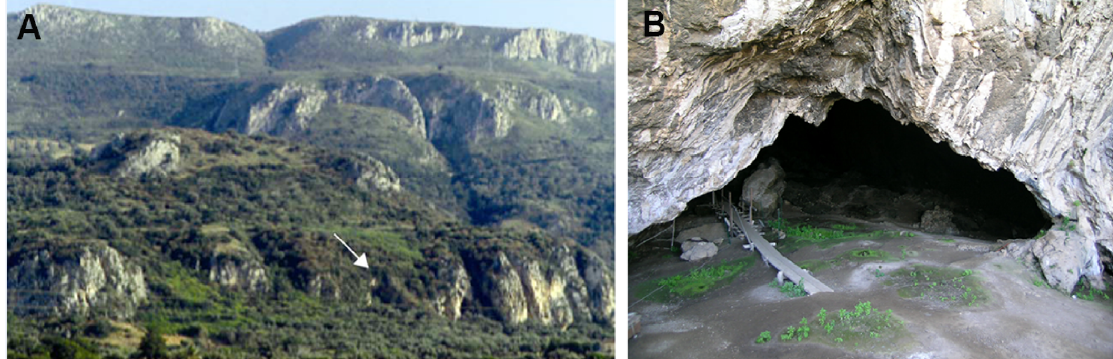
6 of 23 Figure 4. Palaeogeography of Sicily in the middle Pleistocene against present-day coastline (yellow contour). The Hyblean Plateau formed an island separated from the rest of Sicily (from [27], modi- fied). In Sicily five Faunal Complexes (FCs) of Quaternary vertebrate fauna have been dis- tinguished based on bio-events (extinctions and new arrivals) and evolution of endemic species [6,13,14]. Among these FCs, or continental biochronological units, three have been recognised in the examined caves: the P. falconeri FC (early middle Pleistocene, probably MIS 22-11), the Maccagnone (formerly P. mnaidriensis ) FC (late middle Pleistocene, prob- ably MIS 10-4) and the San Teodoro FC (late Pleistocene, 32,000 ± 4000 yr BP, after 230 Th/ 234 U dating on a concretion [30]. 3. Description of the Caves 3.1. San Teodoro Cave The cave opens about two kilometres southeast of the town of Acquedolci (Figure 1)